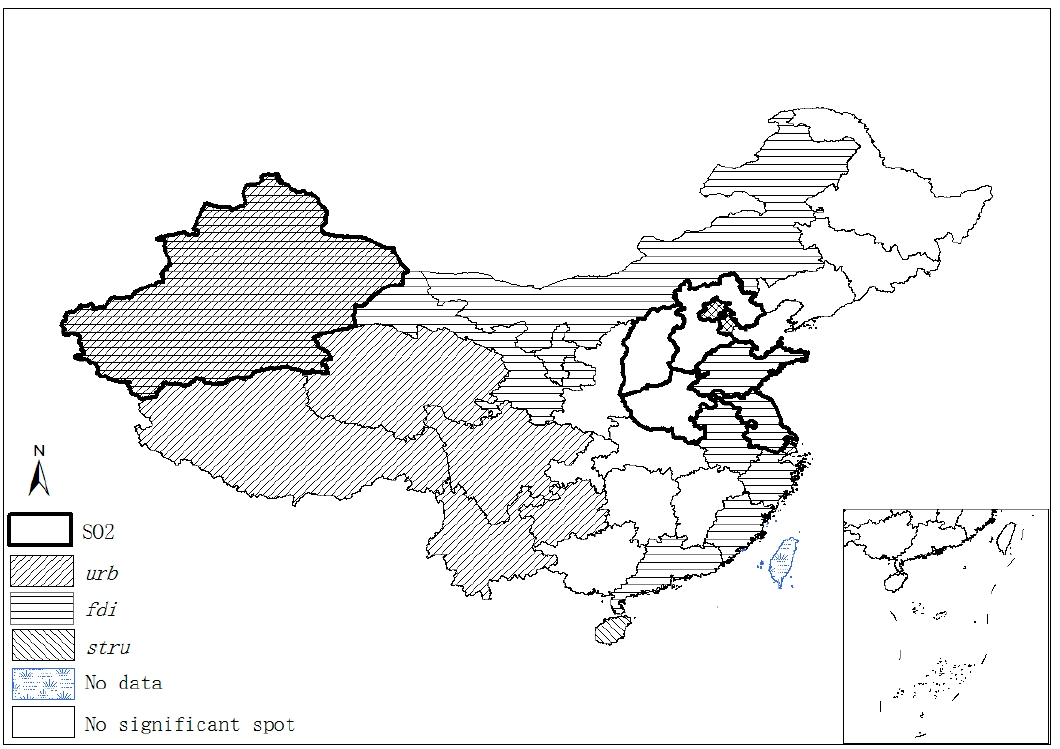
Figure 6. Comprehensive spatiotemporal significant spots.